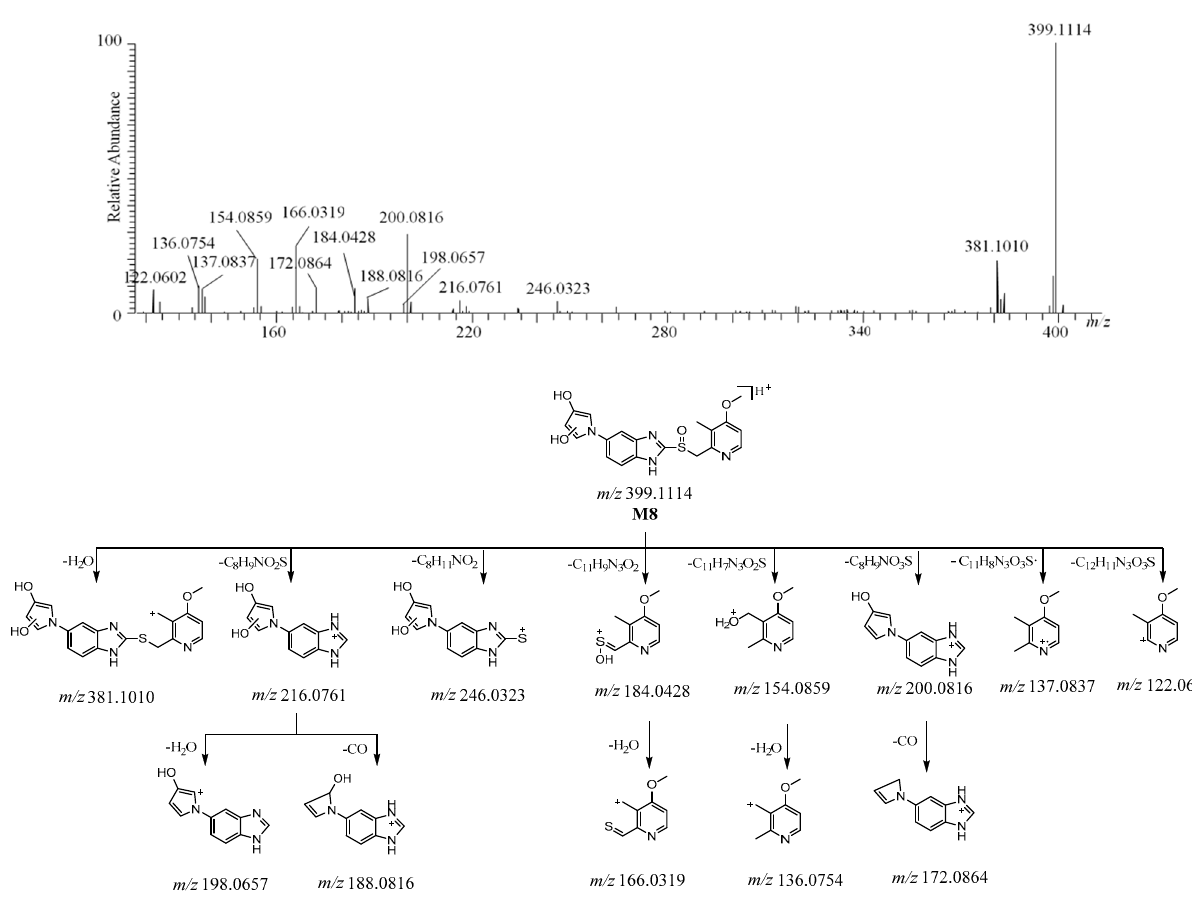
Figure 8. The HRMS/MS spectrum and the possible fragmentation pathway of